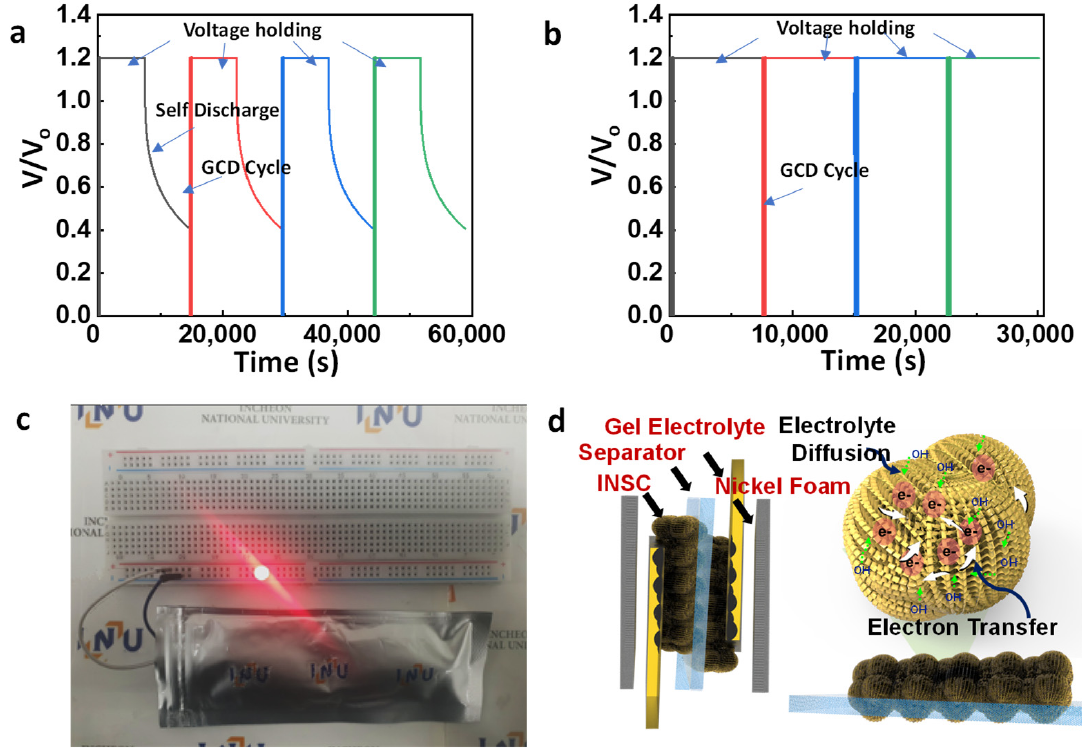
Figure 3. ( a ) GCD (100 cycles) + VHT (2 h) + SD (2 h); ( b ) GCD (100 cycles) + VHT (2 h) for an INSC-based SSC device; ( c ) demonstration of commercial red LED illumination; and ( d ) schematic artwork for illustrating electron transmission at the electrode-electrolyte interface in a fabricated symmetric supercapacitor.